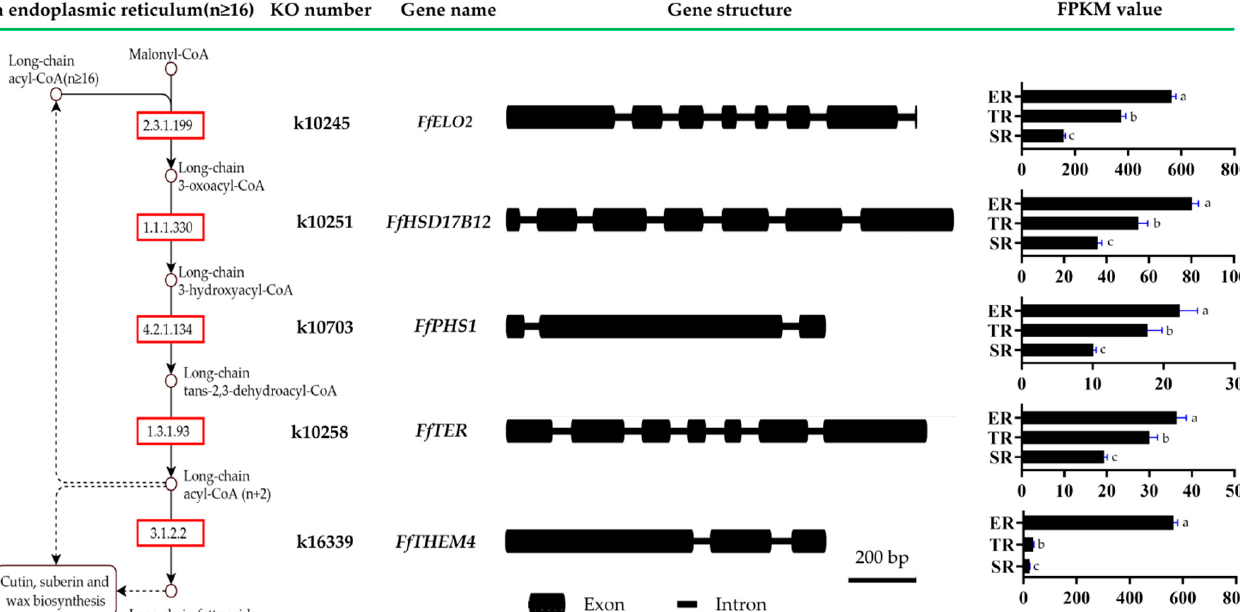
Figure 10. Long-chain fatty acid synthesis of fatty acid elongation pathway (PATH: map00062, Module: M00415) gene structure and expression pattern based on FPKM values of RNA-seq data. Letters over columns denote significant differences ( p < 0.05, n = 3, paired t -test).